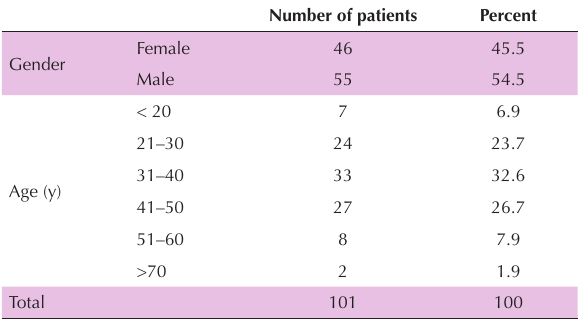
Table 1. Demographic features include age and sex distribution of patients Number of